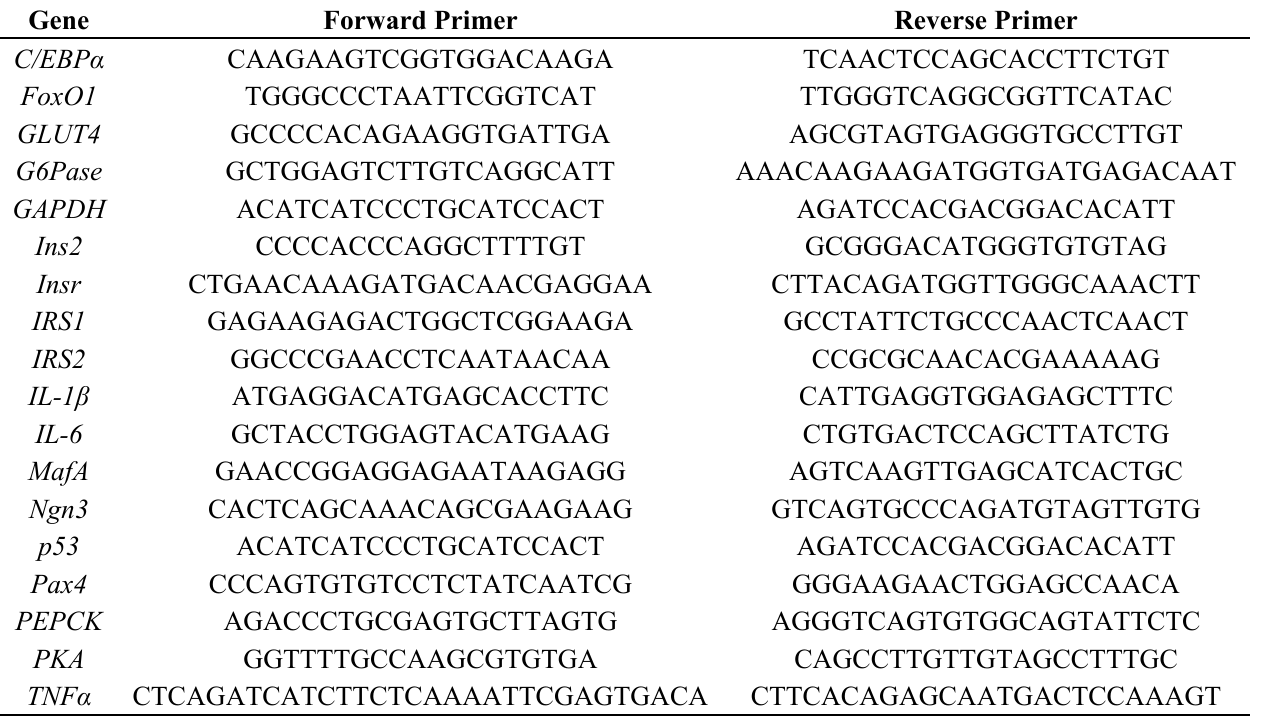
Table 3. Sequences of the primers used in